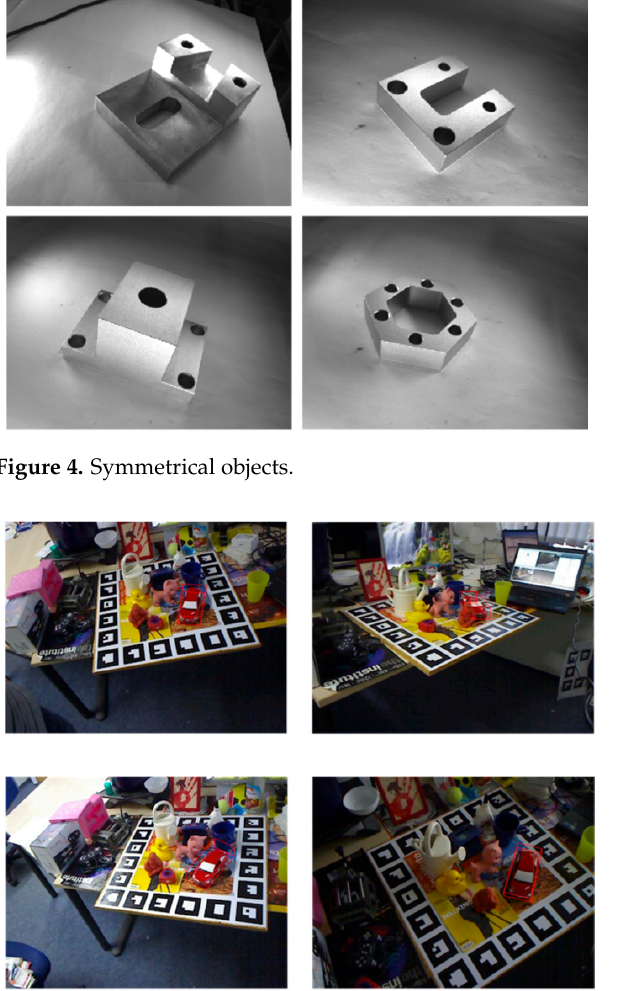
Figure 5. The red bounding boxes for the pose estimation results using